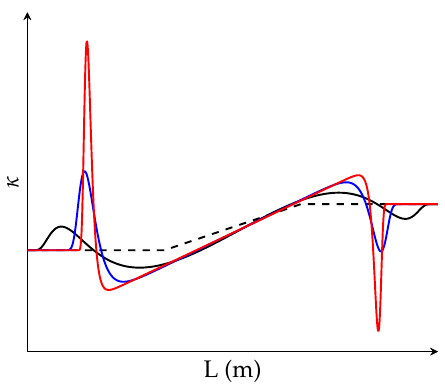
Figure 14. Curvature plots of the clothoid with parts of the circular segments (dashed) and blending splines in [ p 3 , q 3 ] for tightening parameters α , γ = 1,1 (black, default), α , γ = 4,1 (blue), and α , γ = 10,1 (red).